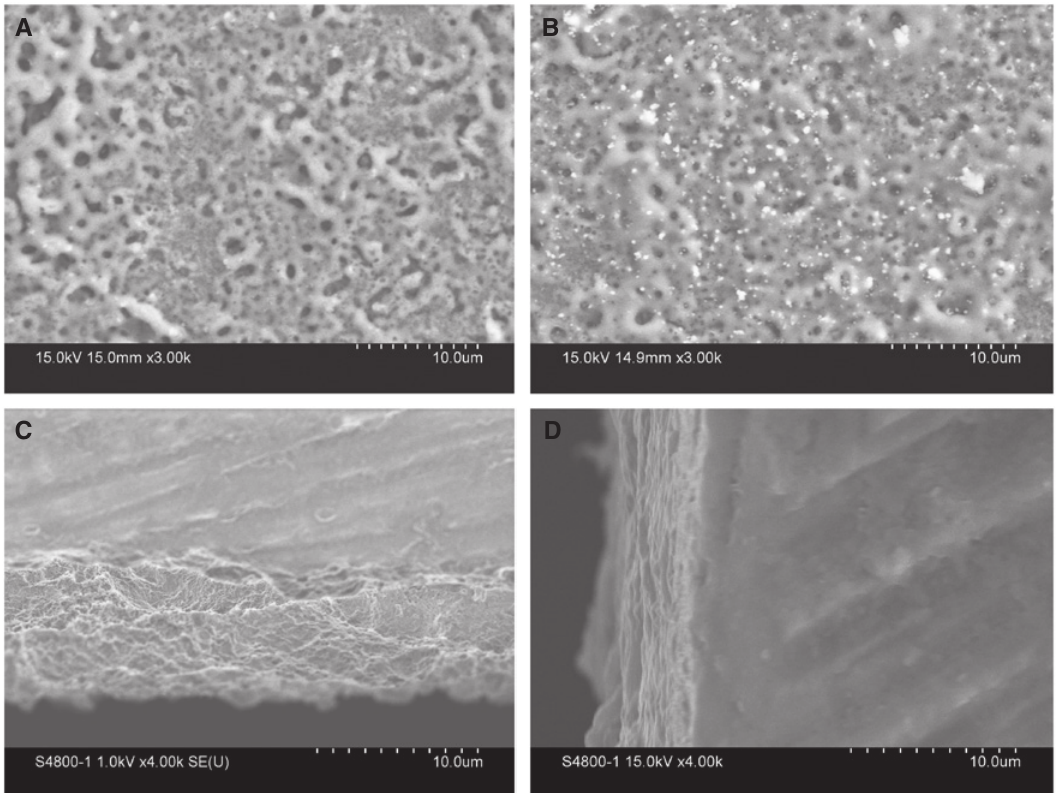
O ceramic coating surface prior to SEM. (B) Added Al 2 3